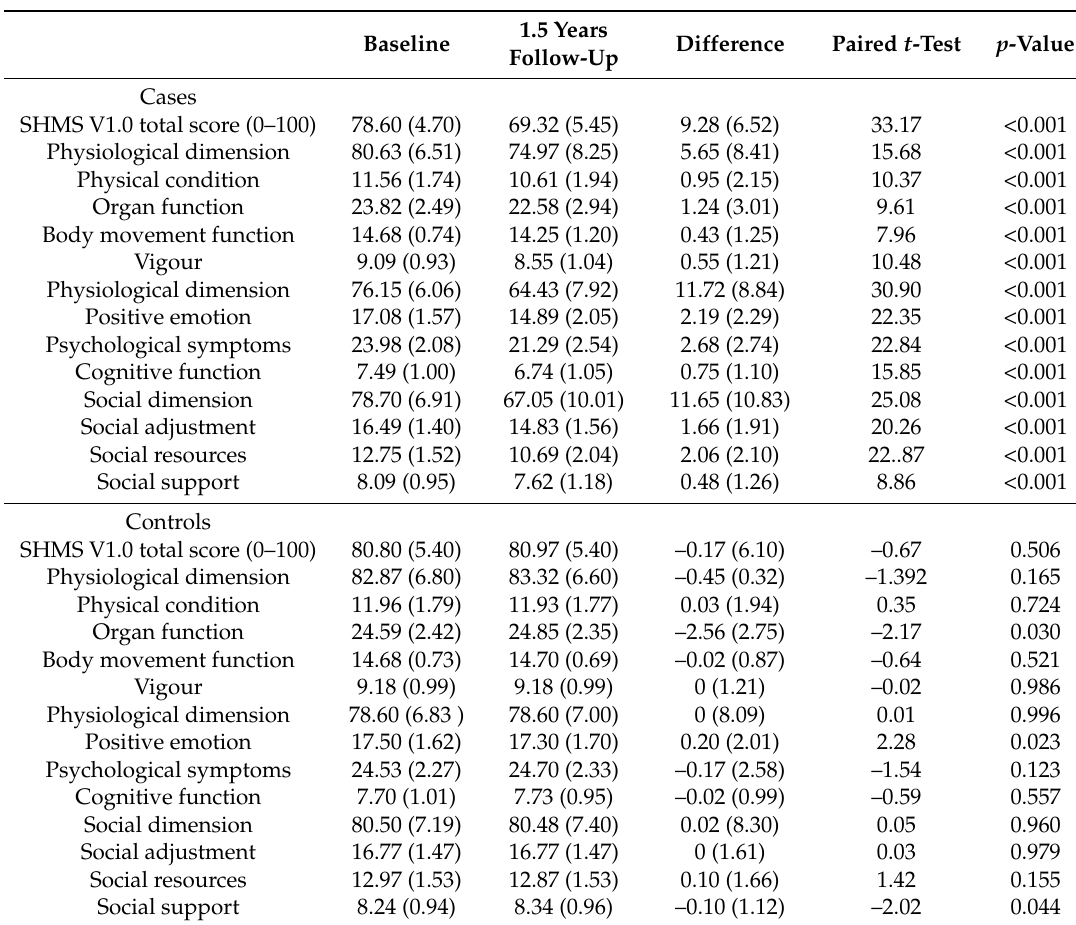
Table 2. Self-reported discomfort assessment by SHMS V1.0 at baseline and at 1.5 years follow-up in cohort of college students participating in the